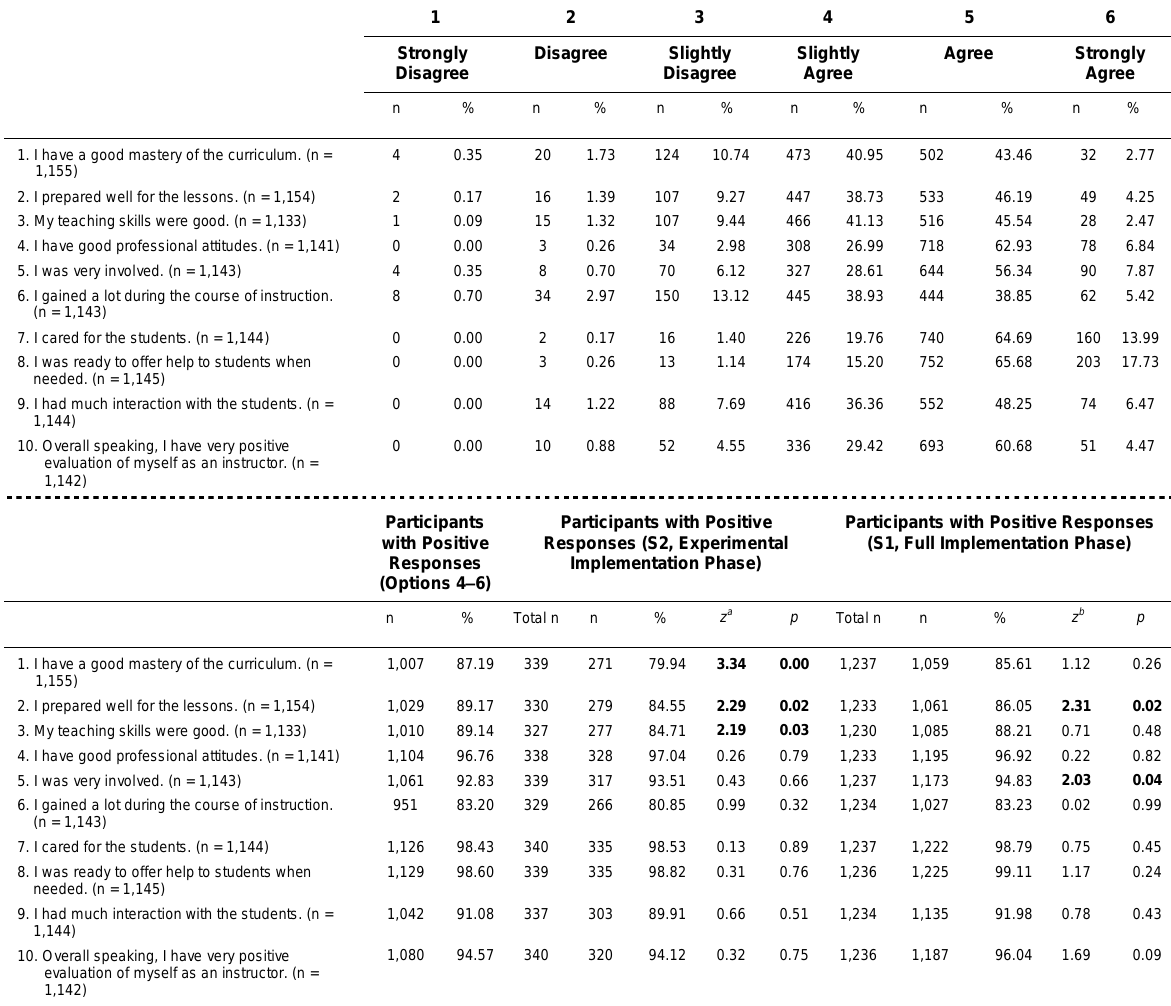
Summary of the Views of the Program Implementers about